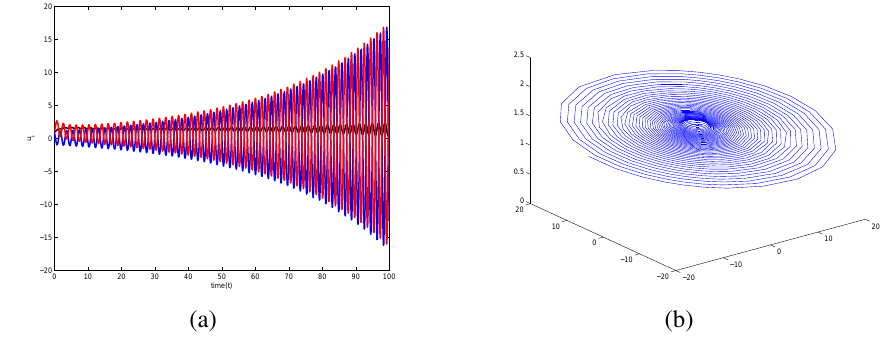
Figure 5: Unstable solutions and phase portrait of system 1 for τ = 0 .